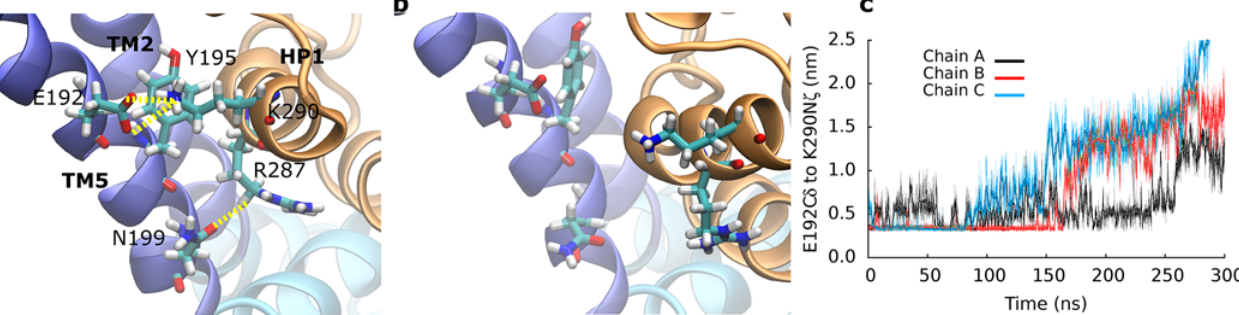
Fig 5. Interactions at the cytosolic site. Interaction network at the cytosolic side (a) in the outward-facing and (b) the intermediate state. (c) Time evolution of the salt bride between E192 and K290. The transporter moves only after opening of the salt bridge.